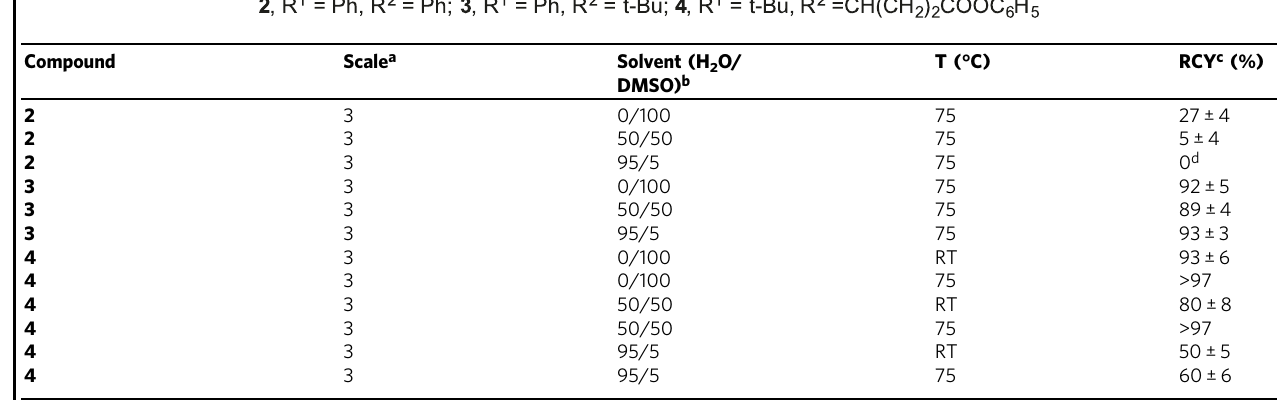
Table 2 RCYs of 18 F-labeled fl uorophosphine synthons under various conditions